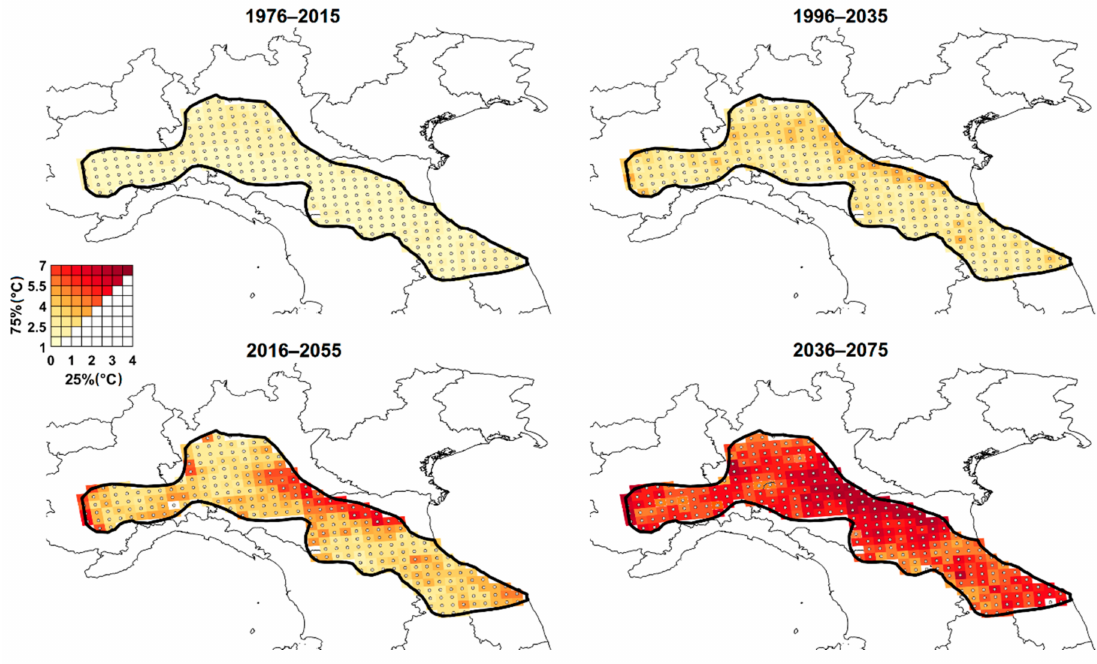
Figure 9. Factors of change for T Min,k in the time windows 1976–2015, 1996–2035, 2016–2055, and 2036–2075 in comparison with the reference time interval 1956–1995—prediction interval (25–75%) map (Scenario